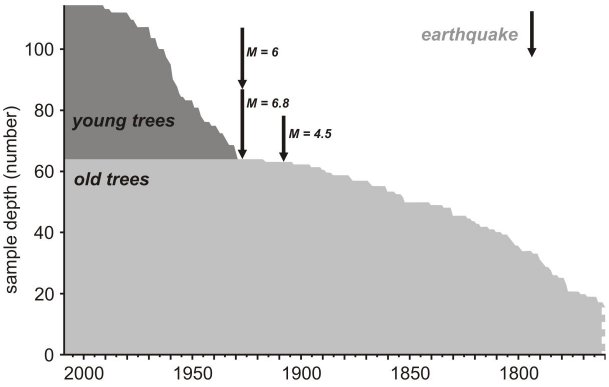
Figure 2: Time evolution of the number of trees (sample depth SD) and earthquake 493 Fig. 2. Time evolution of the number of trees (sample depth SD) and earthquake occurrence ( M >